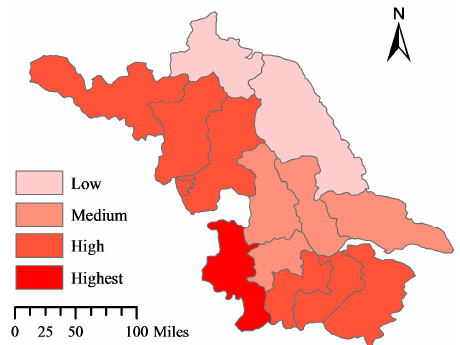
Figure 5. Ecological civilization development in Jiangsu Province.